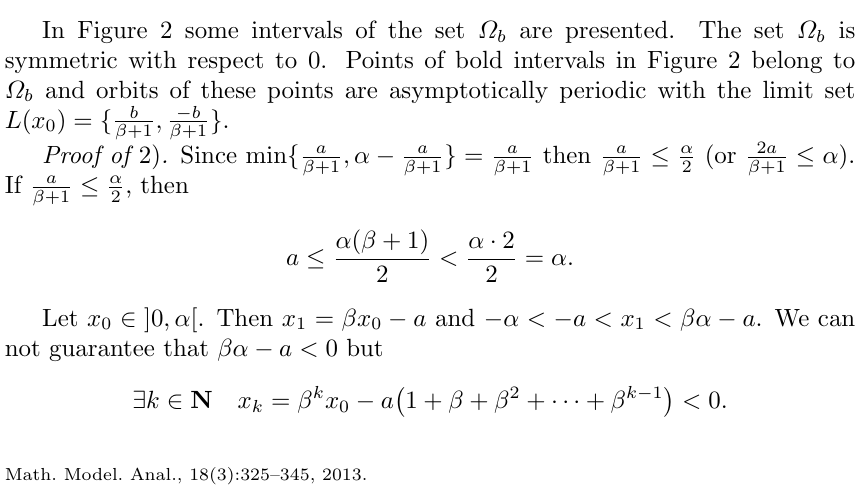
Figure 2. Illustration of Statement 1) of Theorem 4. Presentation of set Ω b